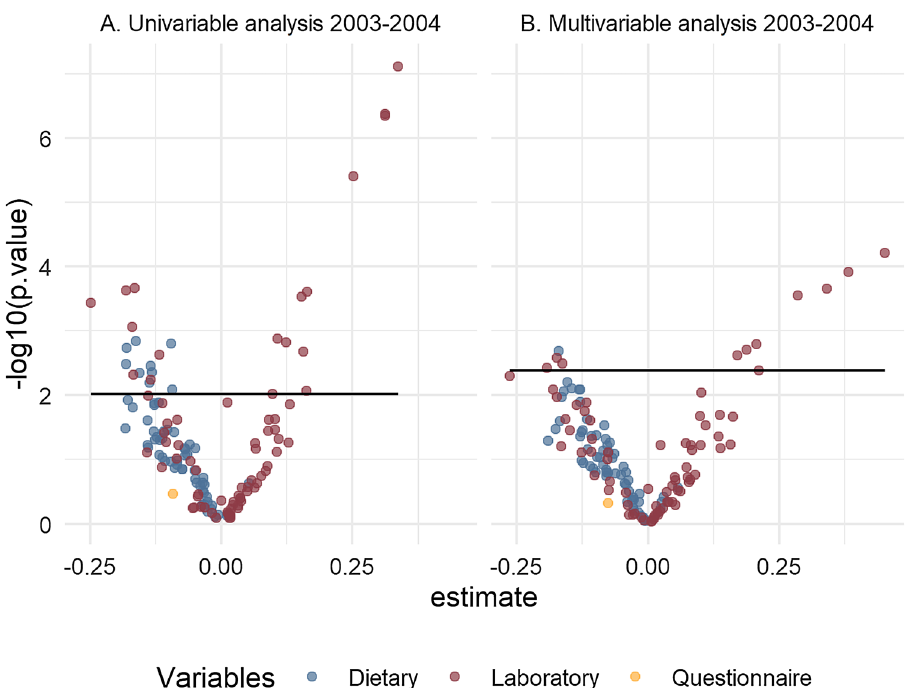
Figure 3. Volcano plots for the univariate and multivariable regressions in the 2003–2004